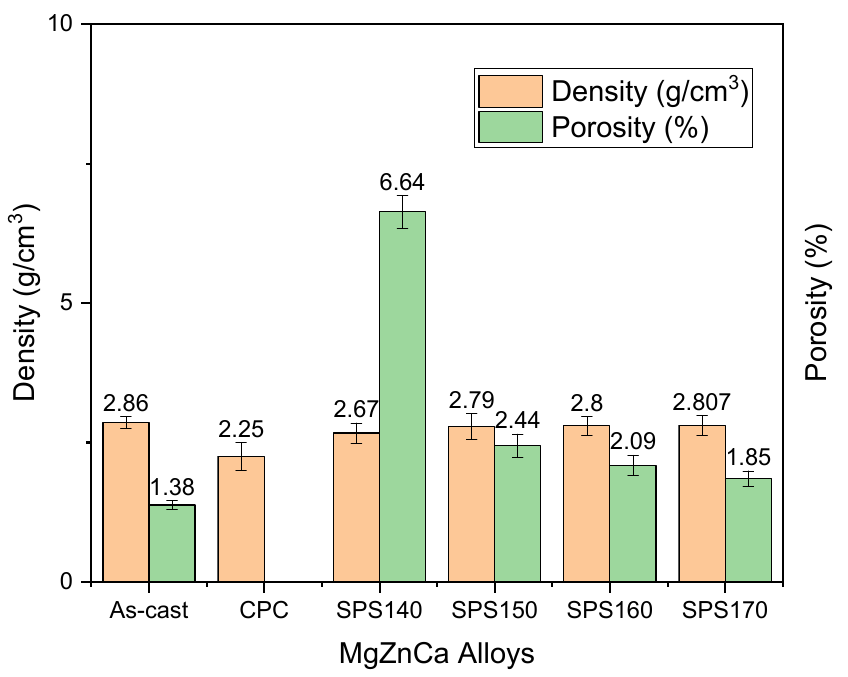
Figure 4. Density and porosity of Mg-Zn-Ca BMGs post-processing as compared to as-cast.